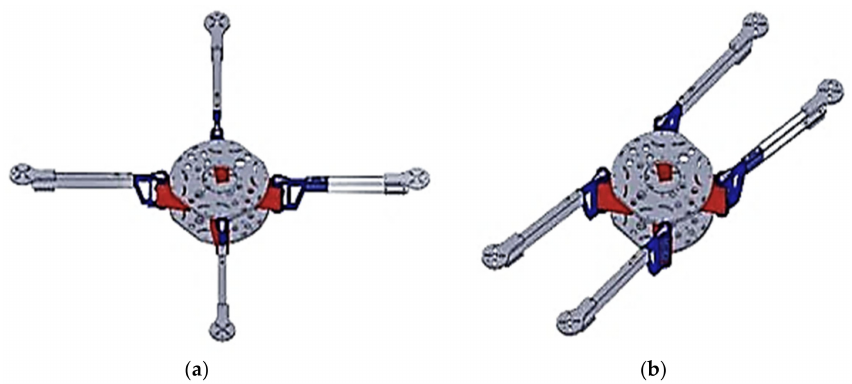
Figure 1. Configurations of MUAV ( a ) The unfolded “X” configuration of MUAV. ( b ) The folded “H” configuration of